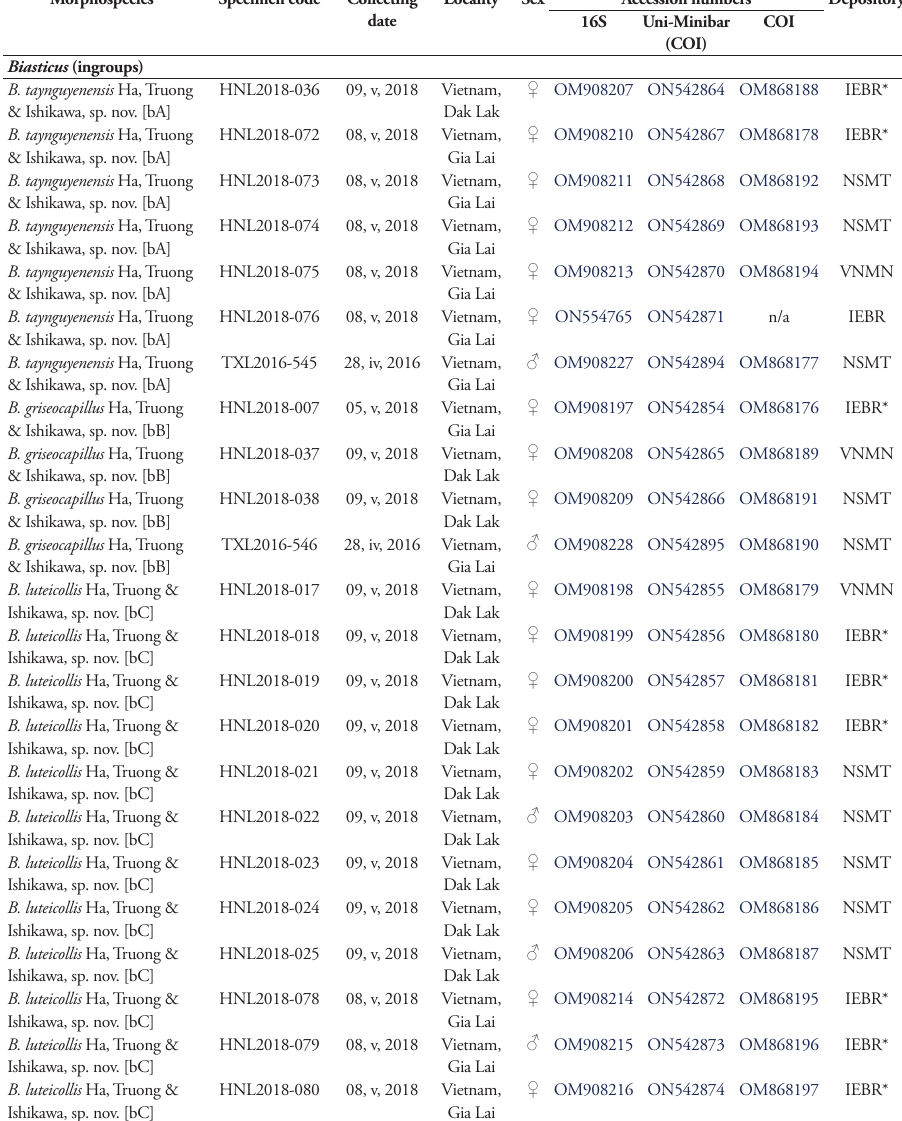
Table 1. The data of specimens used in this study. Abbreviations and symbols: n/a: no data; HU,